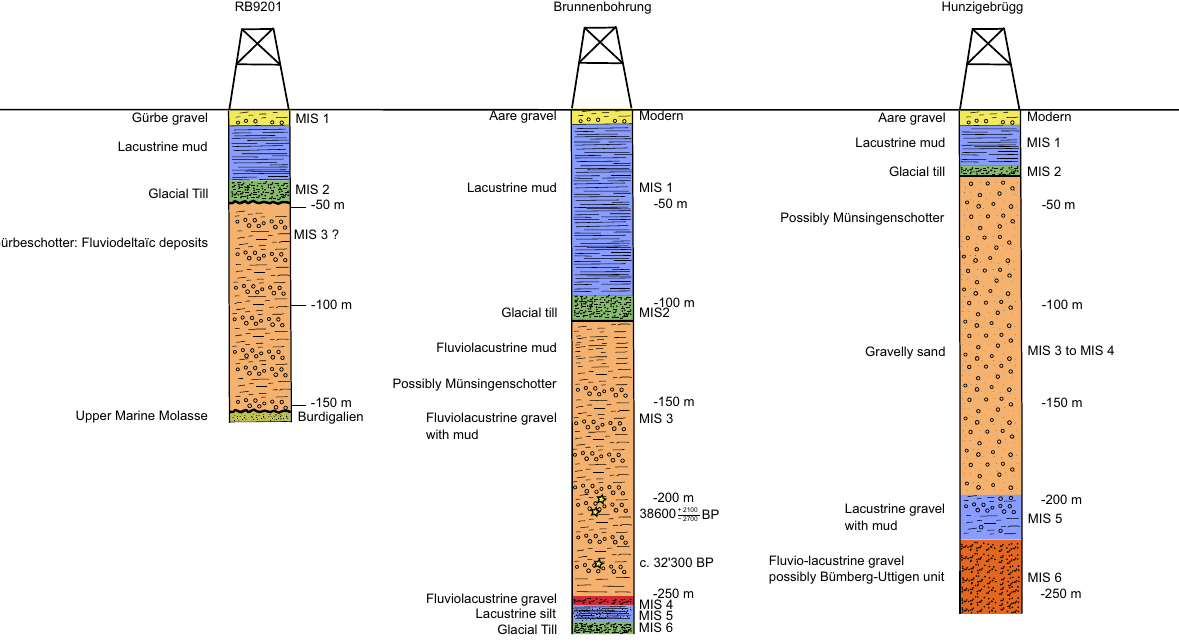
Figure 6. Sedimentary logs. Logs of one drilling in Gürbe valley 31,39 and two drillings in Aare valley 26,33,36 . Information for drawing the log of the Aare valley is taken from the openly accessible database of the Canton Bern. For location of the drillings please refer to Figs. 1b and 2a,b. Different colours represent the various